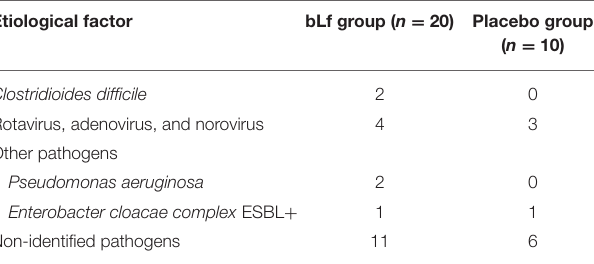
TABLE 3 | Etiological factor of diarrhea. Etiological